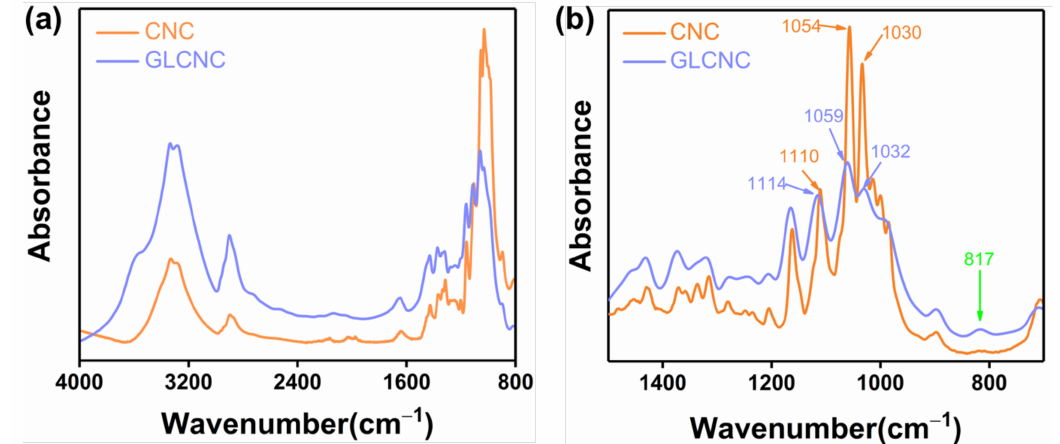
Figure 2. ( a ) ATR-IR spectra of CNCs and GLCNCs in the 4000–700 cm − 1 range; and ( b ) deconvolu- tion of ATR-IR spectra in the region between 1500 cm − 1 and 700 cm − 1